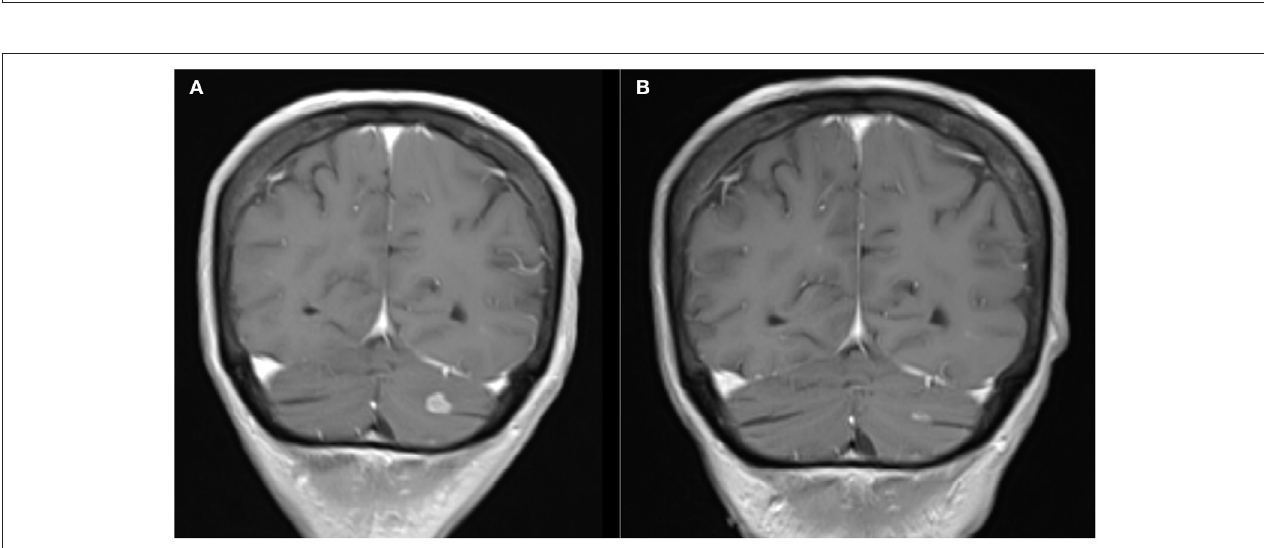
FIGURE 3 | (A) Coronal Brain MRI, T1 with contrast showing a hyperintense lesion in the left cerebellar lobe before systemic therapy with TDM1. (B) Coronal Brain MRI, T1 with contrast showing decrease in the size of the lesion after treatment.